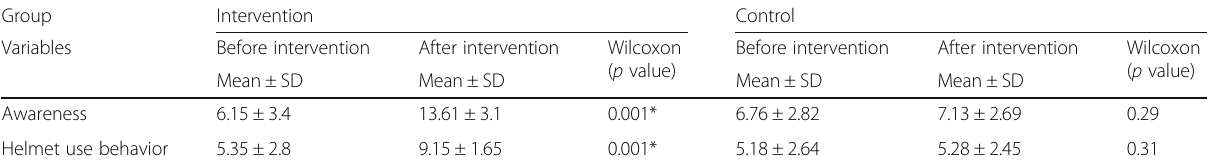
Table 3 The mean scores of awareness and behavior of workers in the intervention and control groups before and after the educational Intervention in Khoy and Urmia, Iran, 2016 Group